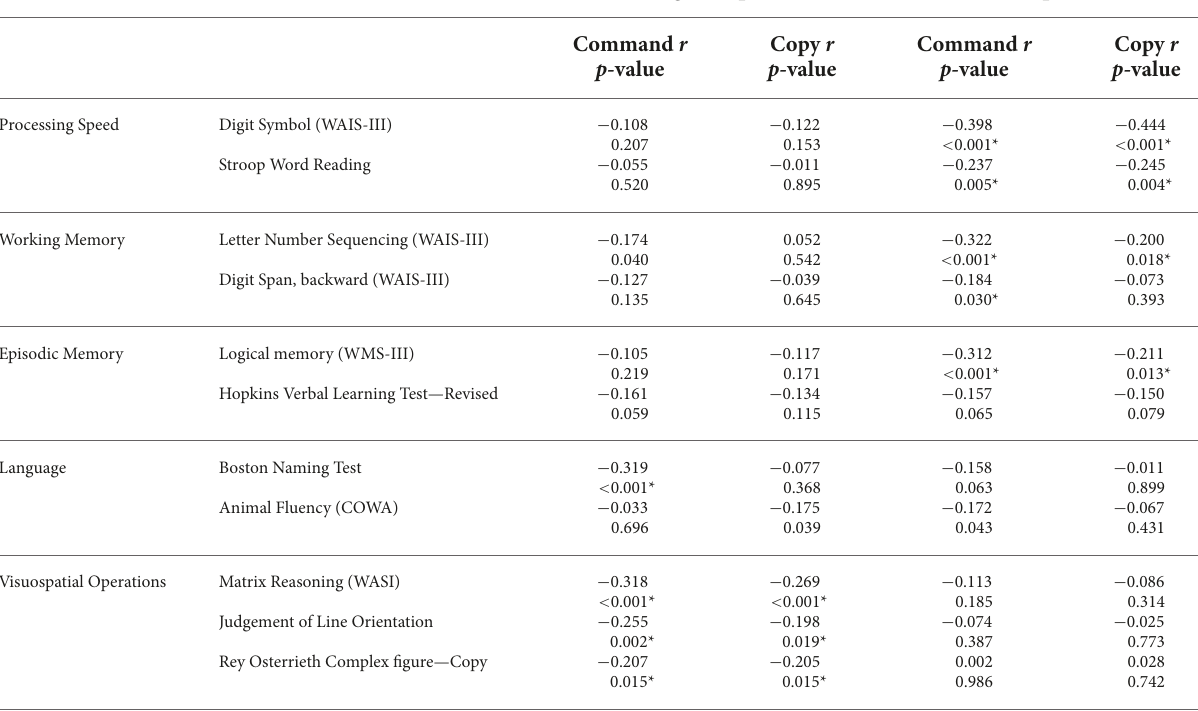
TABLE 3 Partial correlations between digit clock drawing variables (Command and Copy) and neuropsychological tests of interest.